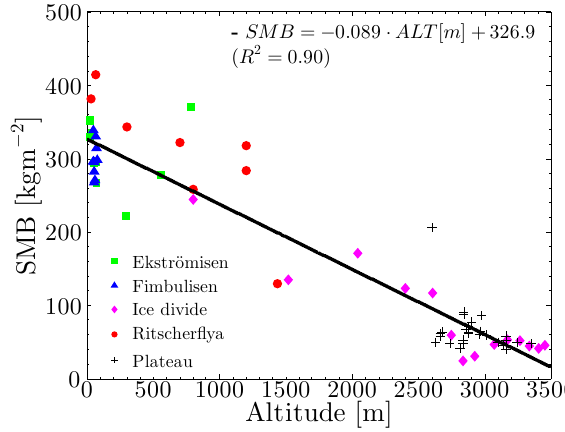
Figure 4. Core average SMB plotted vs. core site altitude. Solid black lines show the respective linear fit to the data. Cores from different regions of the study area are shown in different colours and symbols.